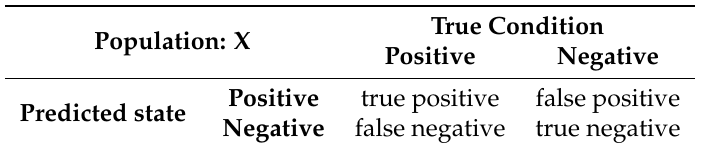
Table 13. Confusion